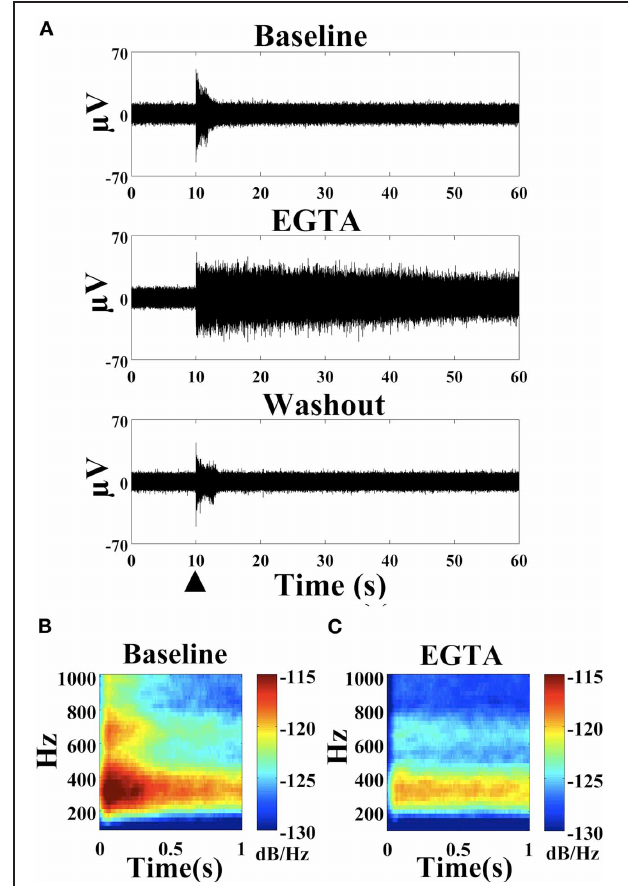
FIGURE 7 | Effect of carbenoxolone (CBX) on the stimulus-evoked oscillation. (A) Three seconds of SALPA filtered trace from two electrodes (hippocampal culture, age six weeks) showing baseline, with 150 μ M CBX, and following washout with 0.5V stimulus (large black arrowhead). TTX 1 μ M was present in the medium. The stimulus-evoked oscillation returned within 10–15min following washout. The oscillation was completely abolished in electrode 2–1 (column-row) and significantly reduced in electrode 3–1. (B) Average power spectra from three cultures (age 5–7 weeks) and 106 electrodes in the presence of TTX 1 μ M and (C) following the addition of CBX 150 μ M.